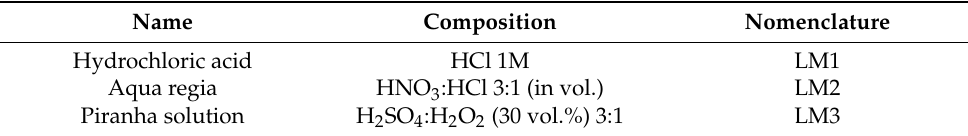
Table 1. Acid leaching solutions used during the purification processing.